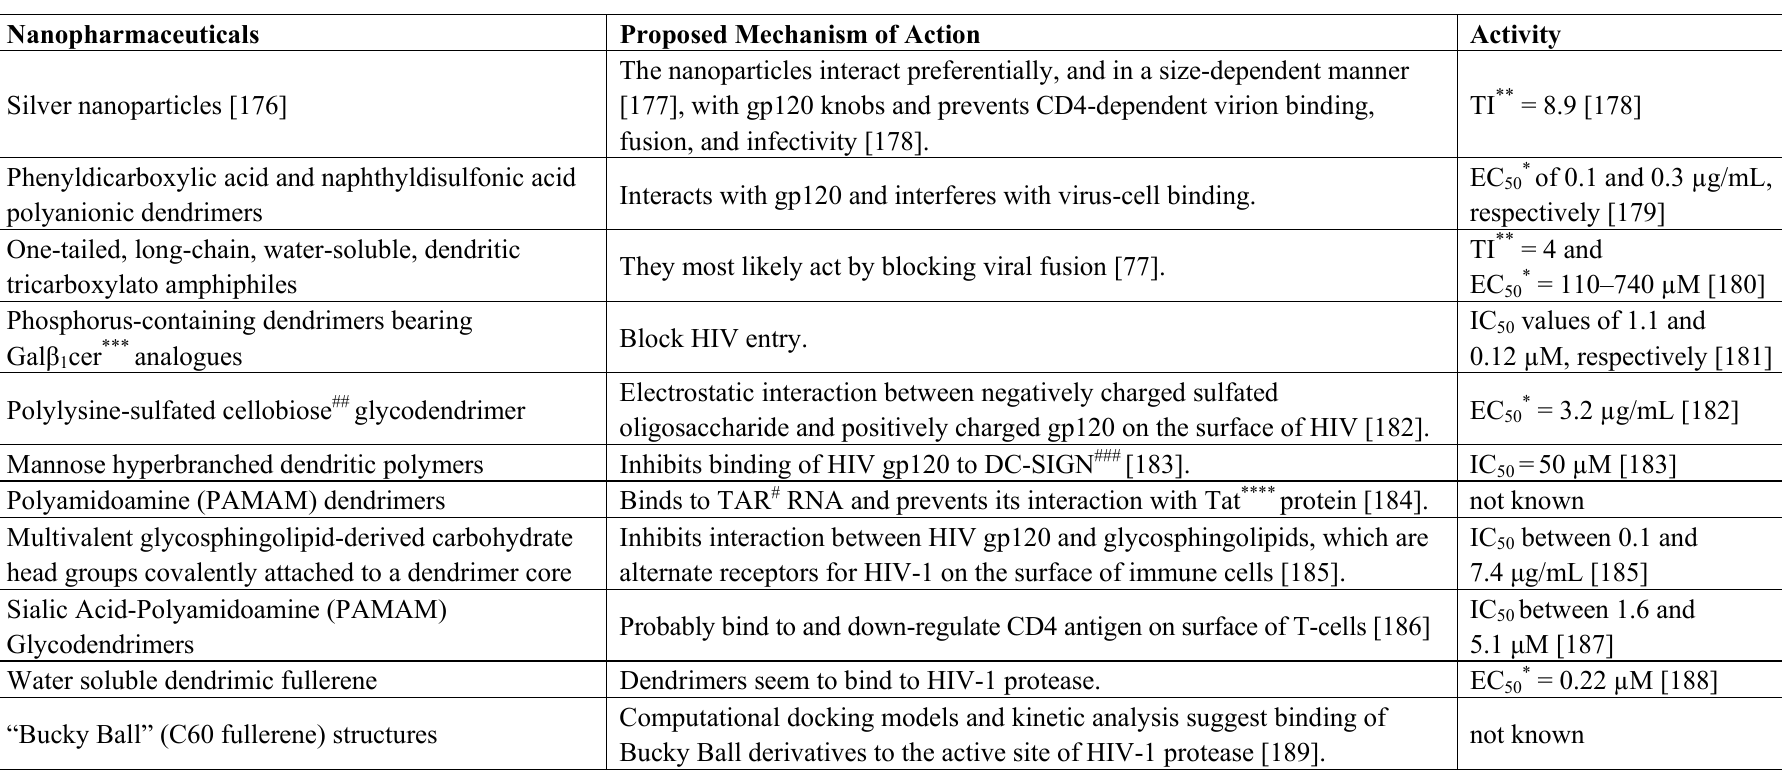
Table 4. Nanopharmaceuticals with potential anti-HIV